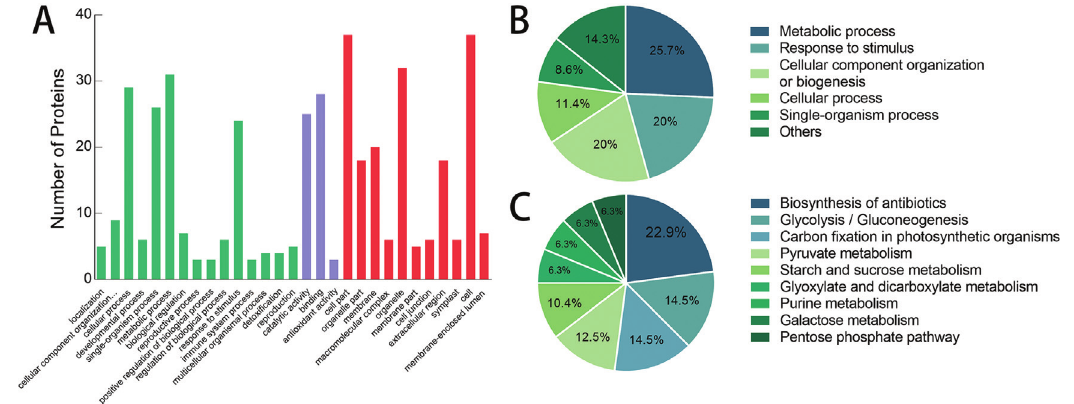
Figure 3 - Annotation and classification of differential proteins according to GO and KEGG pathway analysis. (A) Classification of significantly differ- ential proteins annotated by Blast2GO. (B) Reclassification of the biological processes annotated in (A). (C) KEGG pathway analysis of the differential proteins annotated through